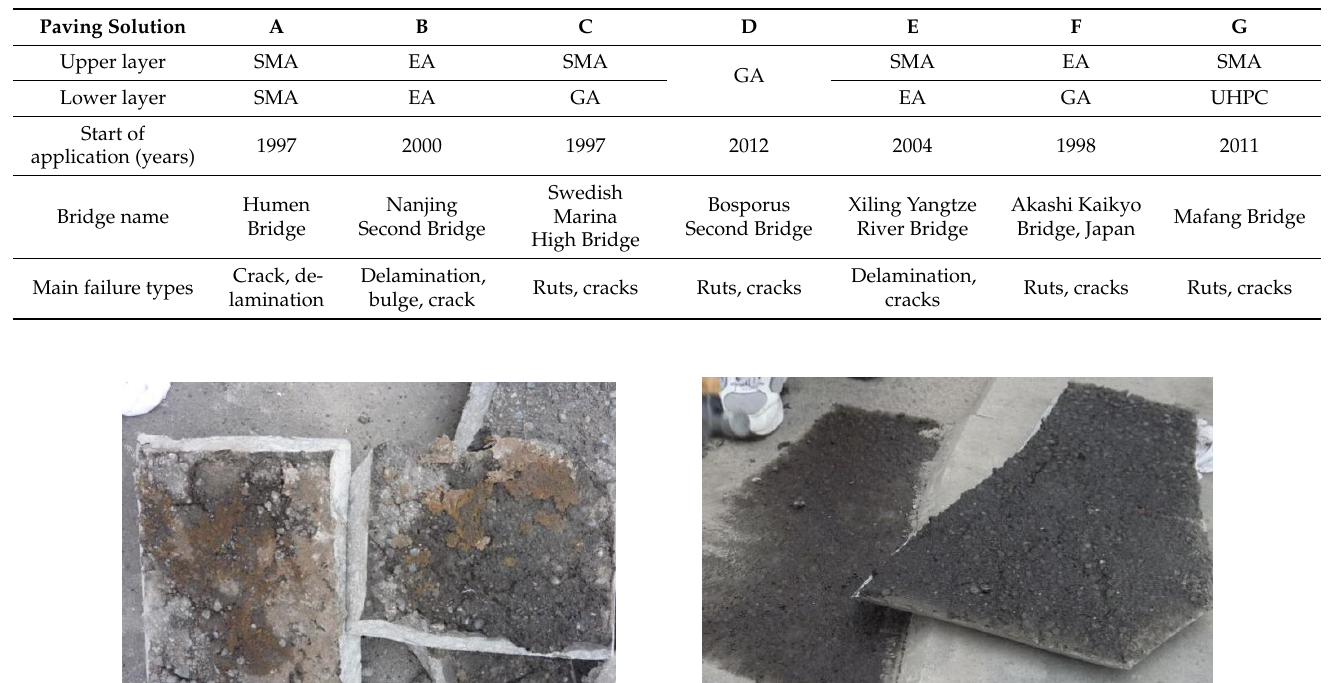
Table 1. Typical steel deck pavement structure options.